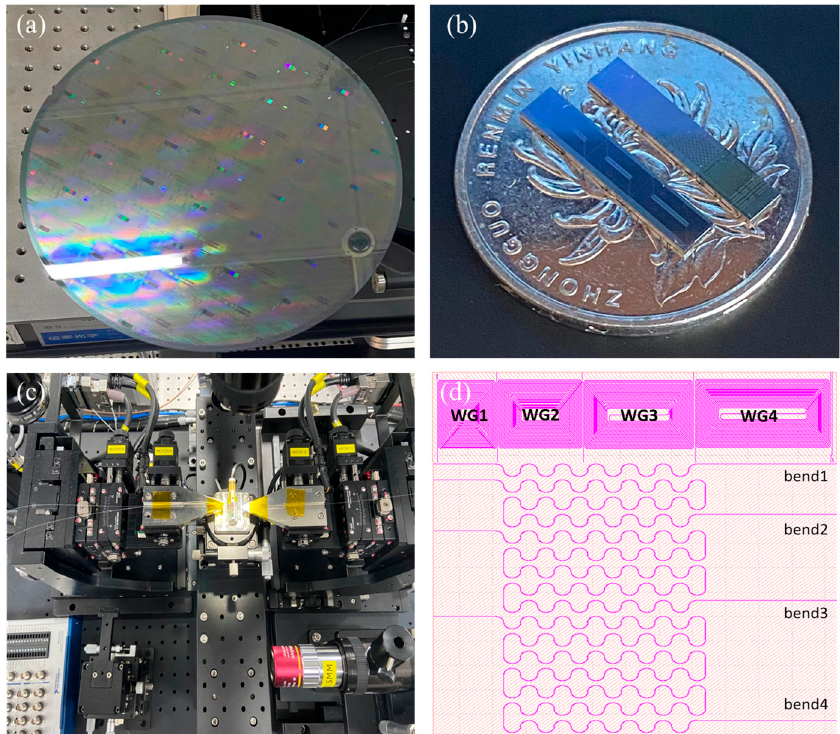
Figure 12. ( a ) Finished 8-inch wafers, ( b ) silicon nitride chips, ( c ) semi-automatic test platform, ( d ) layout design of the spiral and bending waveguides for the test. Table 2. Structural parameters of the cutback structure.